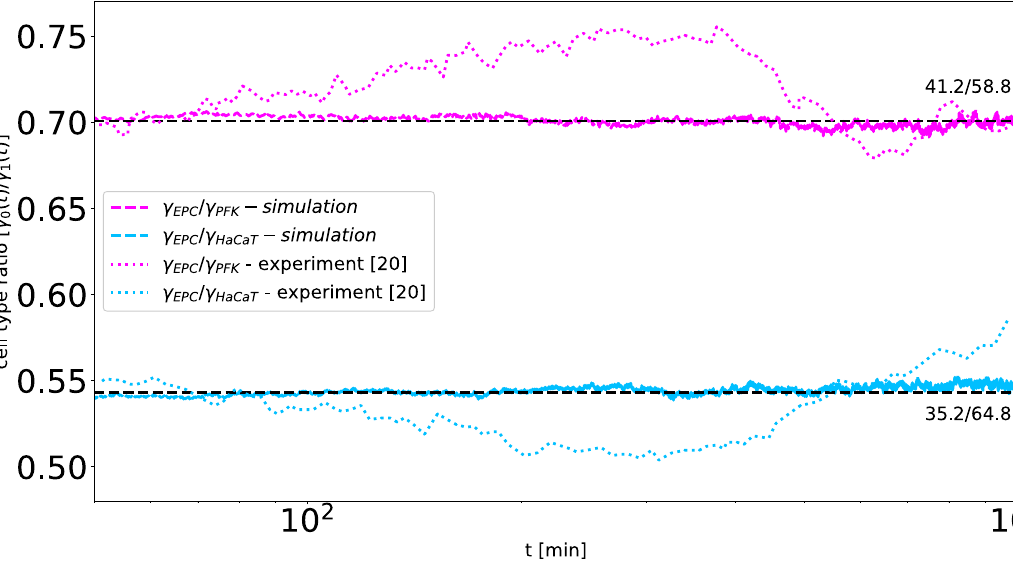
Fig 11. The cell type ratio for the simulation can be obtained from the experiments of Me´hes et al. [20]. Shown is a comparison of the cell type ratio r = γ 0 ( t )/ γ 1 ( t ) from the experiments of Me´hes et al. [20] (dotted in color) and from the cellular automaton (dashed in corresponding color). The cell type ratio in the cellular automaton is set to the approximate mean of the ratios observed in the experiment (dashed black lines). The cell type ratio was calculated by the ratio of the type specific segregation indices for each time t per experiment EPC with PFK (red) and HaCaT with EPC